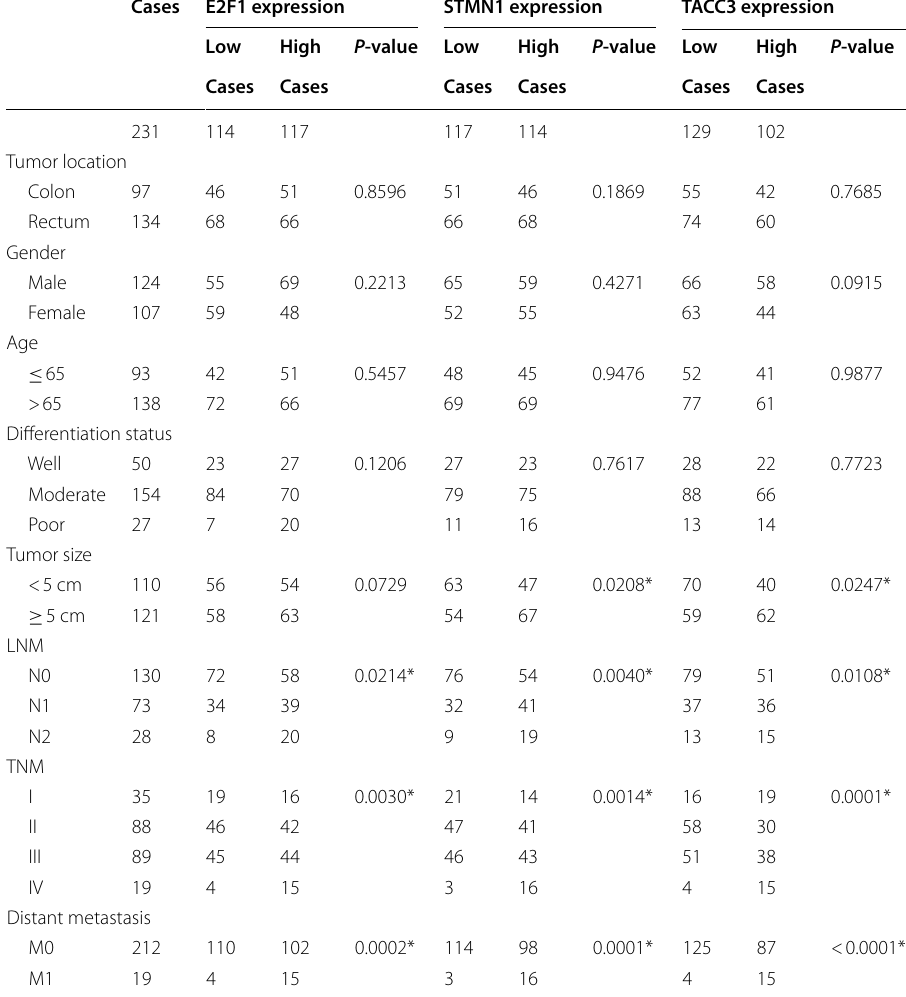
Table 1 Association of the expression of E2F1, stathmin1, and TACC3 with clinicopathological features in CRC